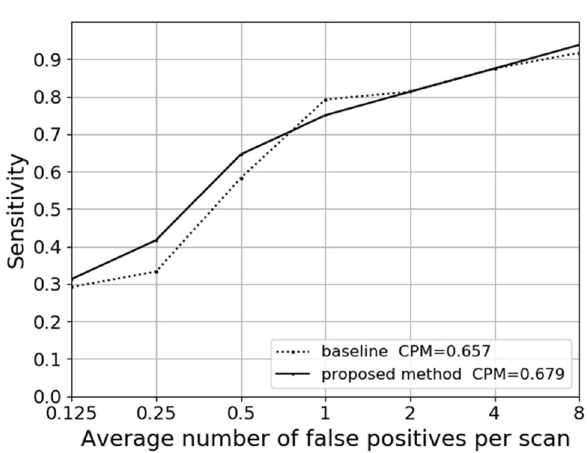
Figure 9. FROC curves obtained by baseline and the proposed methods on TianChi dataset.